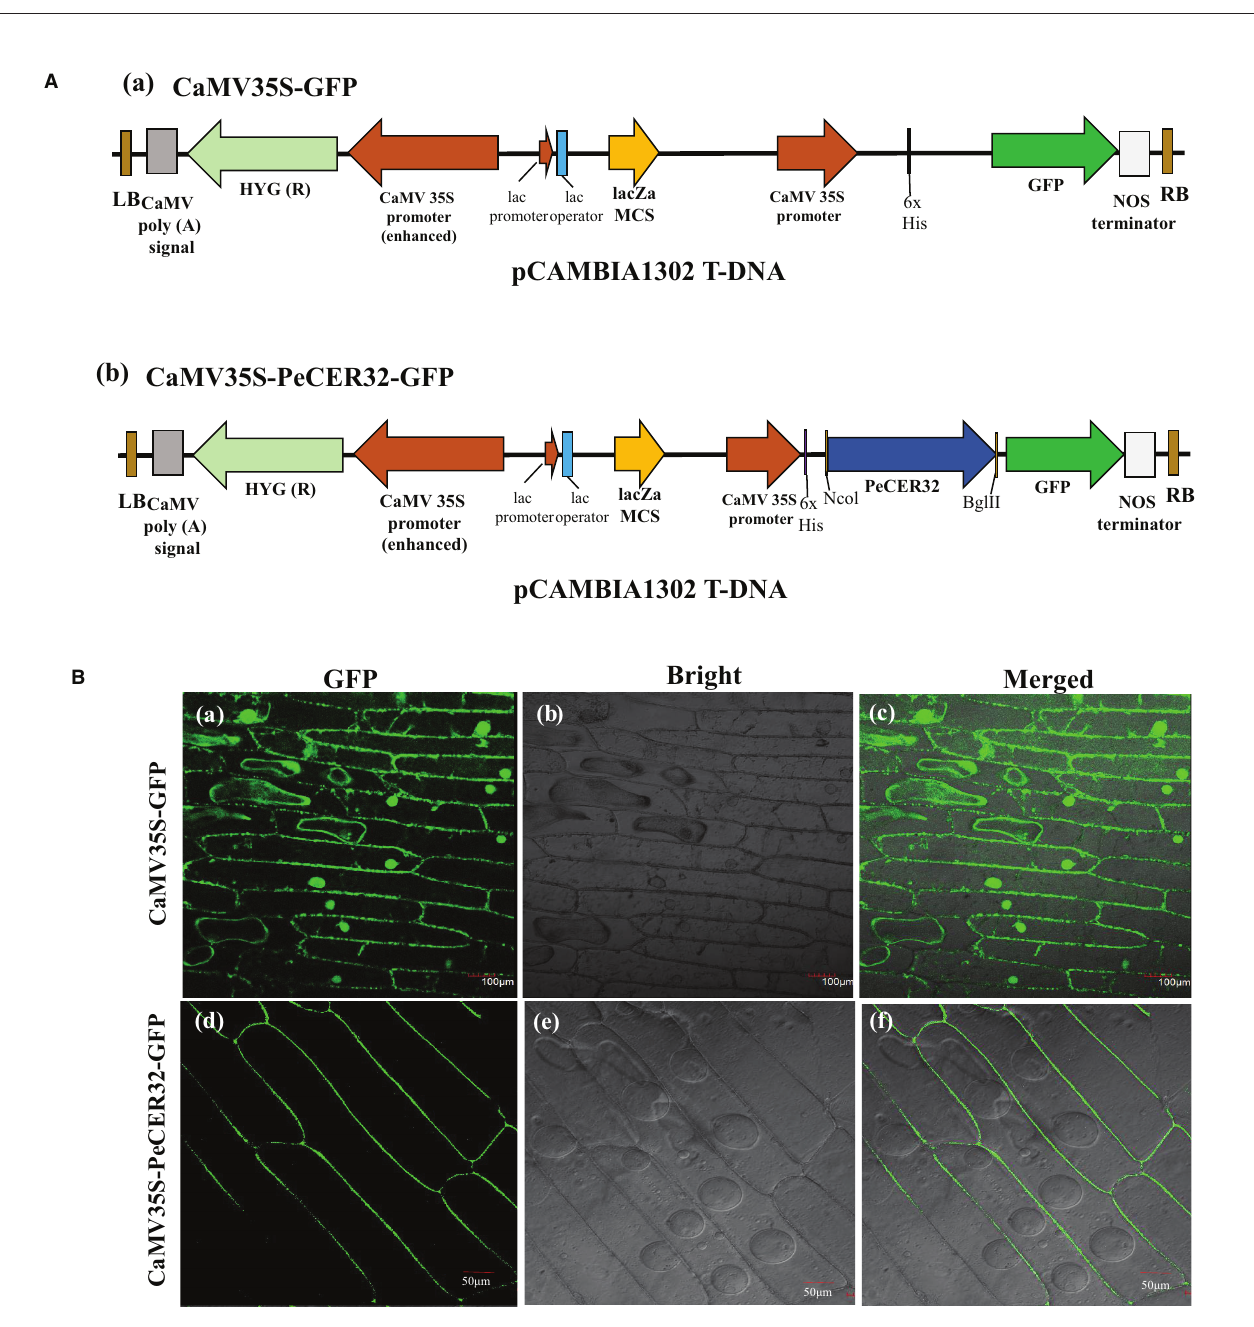
FIGURE 9 | Subcellular localization of GFP-fused PeCER32 protein based on transient expression assays in onion epidermal cells. (A) (a) Structure of CaMV35S-GFP as empty vector. (b) Structure of CaMV35S- PeCER32 -GFP as construct. (B) (a–c) Onion cells transformed with CaMV35S-GFP as control (scale bar = 100 µ m). (d–f) Onion cells transformed with CaMV35S- PeCER 32-GFP (scale bar = 50 µ m). (a,d) GFP signals visualized under dark field. (b,e) Onion epidermal cells under bright light. (c,f) represent merging of (a,b,d,e).